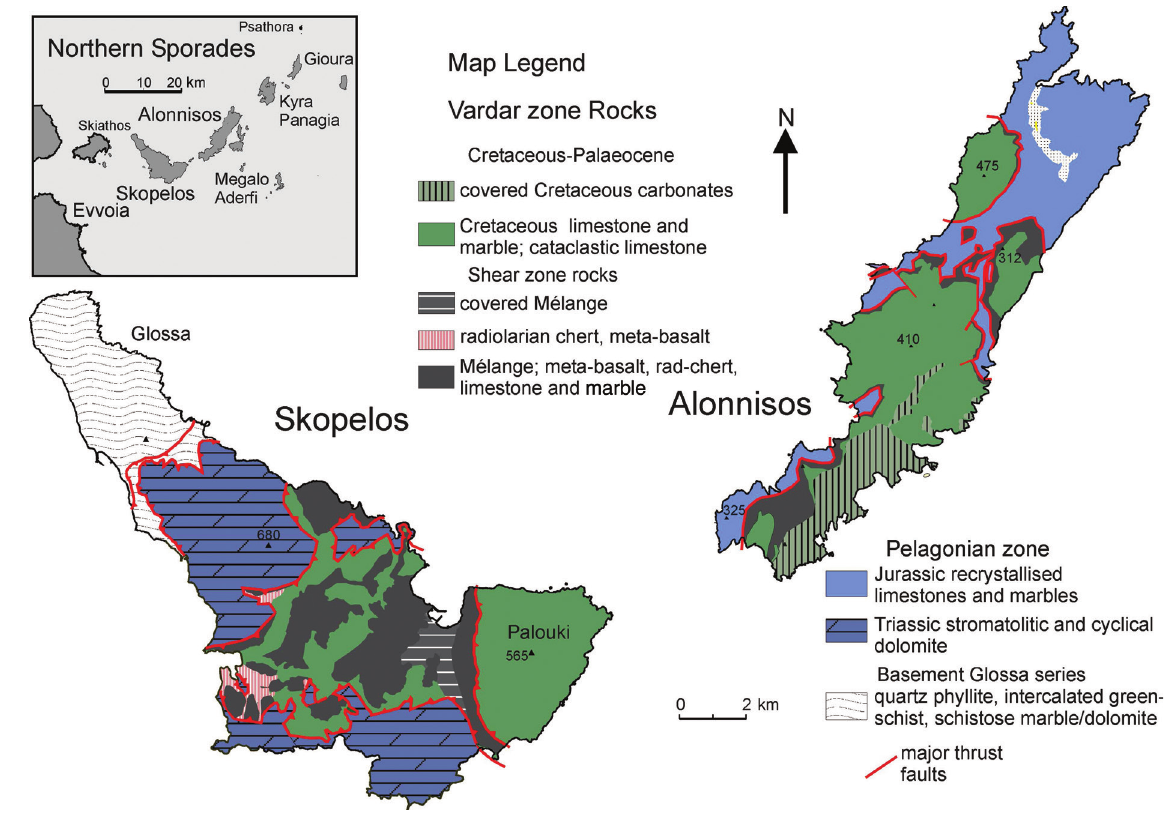
Overview geological map of Skopelos and Alonnisos in the Northern Sporades (based on Matarangas [87]; Kelepertsis [54] and Scherreiks and BouDagher- Fadel [10]). The Cretaceous limestone formation of Alonnisos and Skopelos lies tectonically emplaced, together with a sheared mélange of metamorphic ocean-floor basalt and radiolarian chert, on top of the post-Eohellenic erosional unconformity over Pelagonian Upper Jurassic limestone on Alonnisos and Upper Triassic dolomite on Skopelos. It has been postulated that the tectonic emplacement took place during Paleocene time as Pelagonia underthrust the Cretaceous forearc basin of the Vardar volcanic arc